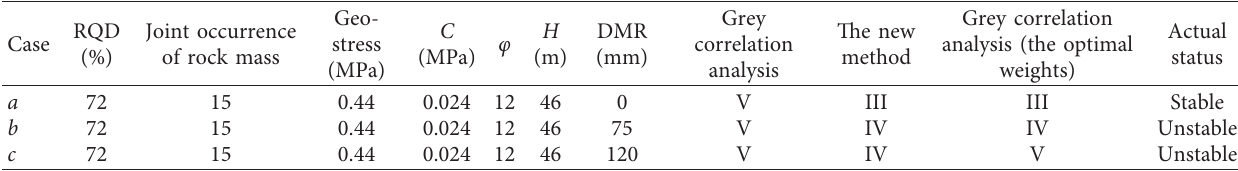
Table 4: Actual data of index and evaluation results of slope stability.